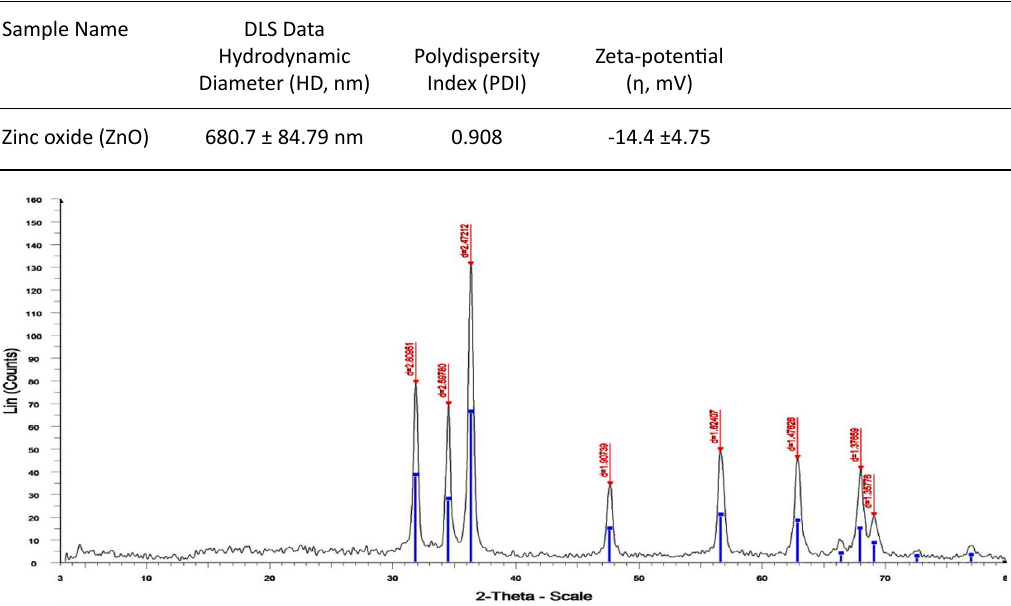
Table 2. DLS and zeta-potential measurements of green synthesized ZnO NPs